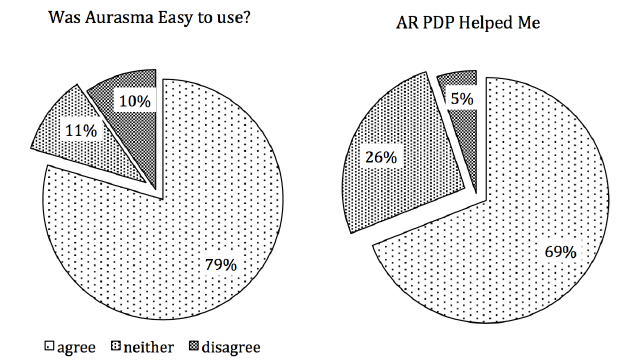
Figure 1. Student responses from the